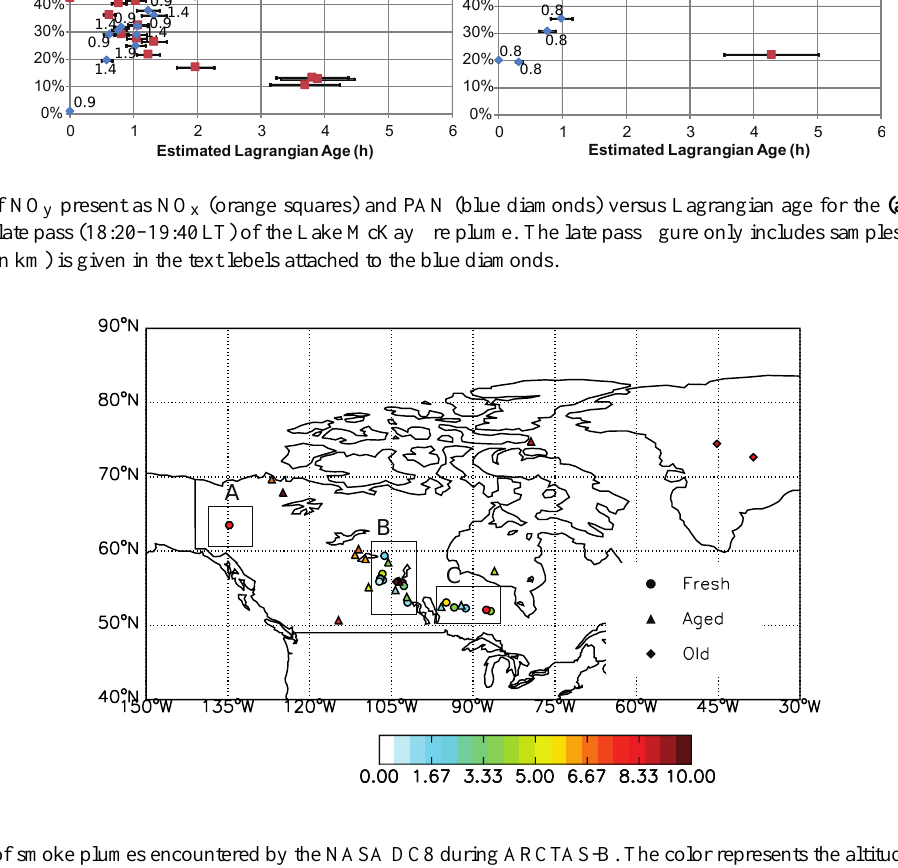
Fig. 5. Locations of smoke plumes encountered by the NASA DC8 during ARCTAS-B. The color represents the altitude of the plume while the symbol represents the age